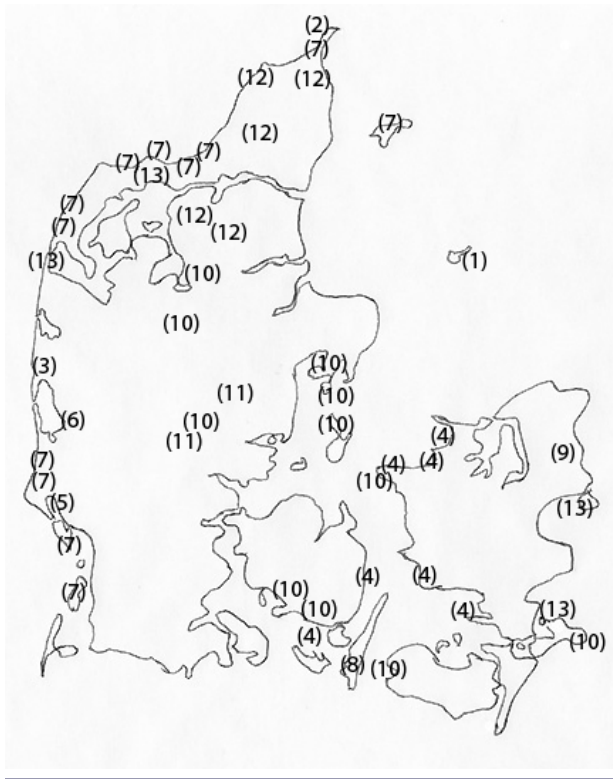
Fig. 1 . Sites included in the analyses. Projects are identified by numbers, following the same chronology used in Table 1. (1) Anholt, one site; (2) Hulsig Heath, one site; (3) Vest Stadil Fjord, one site; (4) Bombina bombina , seven sites; (5) Wadden Sea, one site; (6) Skjern River, one site; (7) Dune Habitats, 12 sites; (8) Tryggelev Nor, one site; (9) Lake Fure, one site; (10) Dry Grasslands, 11 sites; (11) Triturus cristatus , two sites; (12) Euphydryas aurinia , five sites; (13) Meadow Birds, four sites. Sites outside Denmark in the Triturus cristatus project are not